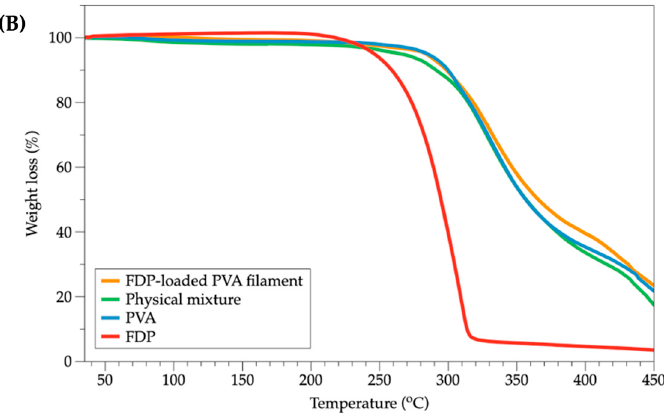
Figure 4. ( A ) DSC thermograms and ( B ) TGA thermograms of FDP, pure PVA, physical mixtures of FDP and PVA, and FDP ‐ loaded PVA filaments.